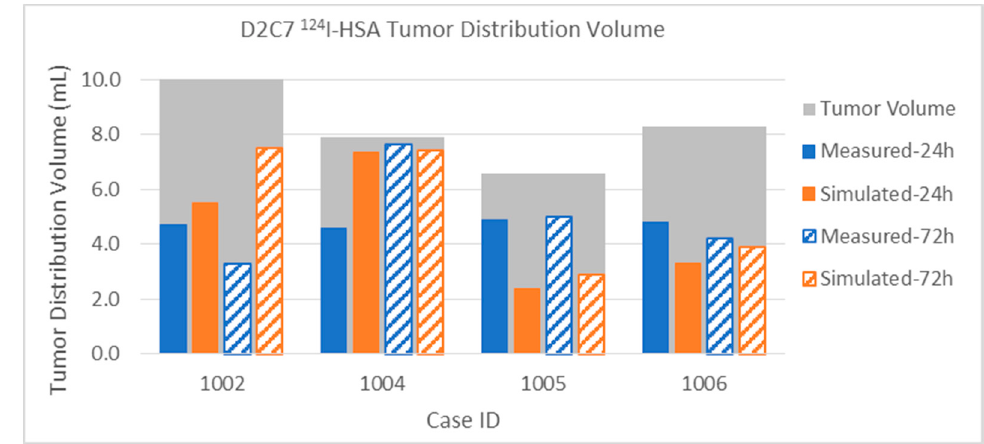
Figure 15. Comparison of measured and simulated 124 I-HSA distribution within contrast-enhancing tumor in D2C7 patients. Gray bars show tumor volume.